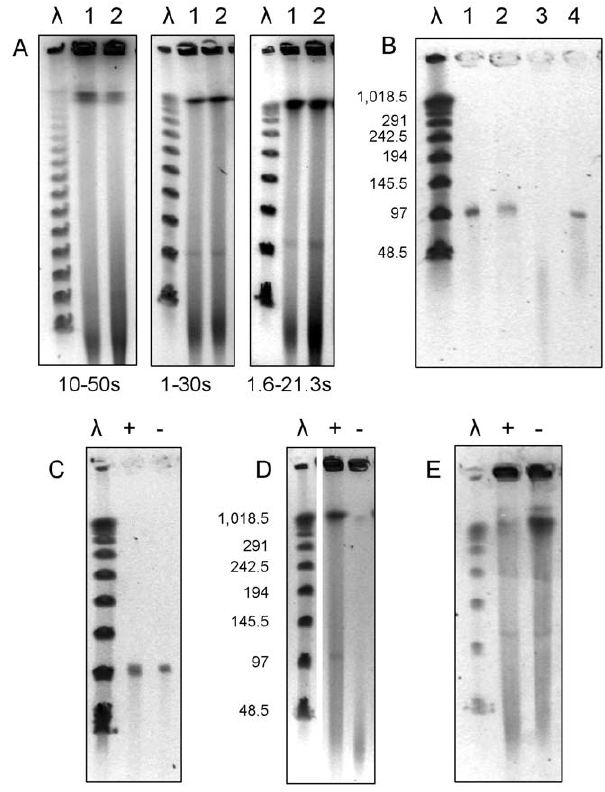
Figure 2. PFGE of DNA genomic preparations. (A) PFGE with undigested DNAs from M. avium 88.3 (1) and M. kansasii 88.8 (2) under different switch times, indicated below each figure; (B) pMA100 extracted from PFGE gels and treated with exonuclease III (3) or exonuclease lambda (4); (C) pMA100 extracted from PFGE gels and treated ( + ) or not (-) with topoisomerase I; (D) DNA prepared with ( + ) or without (-) adding proteinase K to the lysis buffer; (E) same as in (D) in PFGE gels and running buffer prepared with 0.2% SDS. l : DNA concatemers of the bacteriophage l genome.